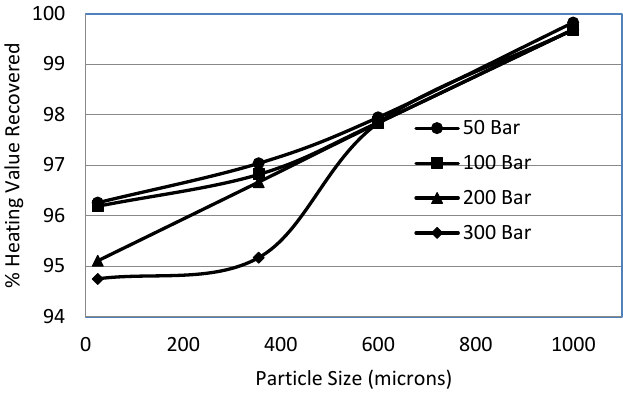
Figure 12. Effect of particle size on heating value recovery.